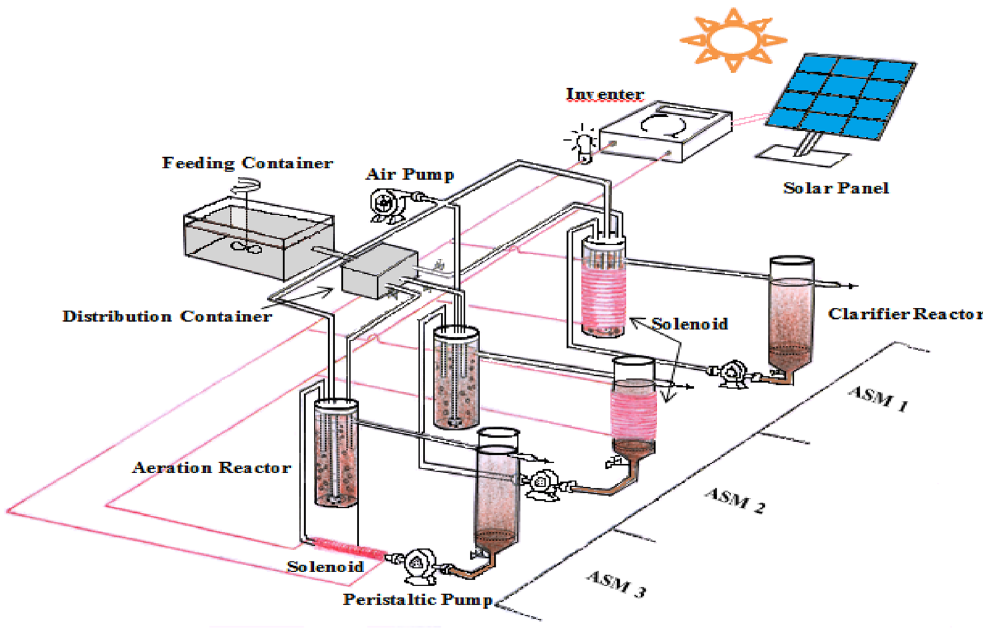
Figure 1. Schematic of the